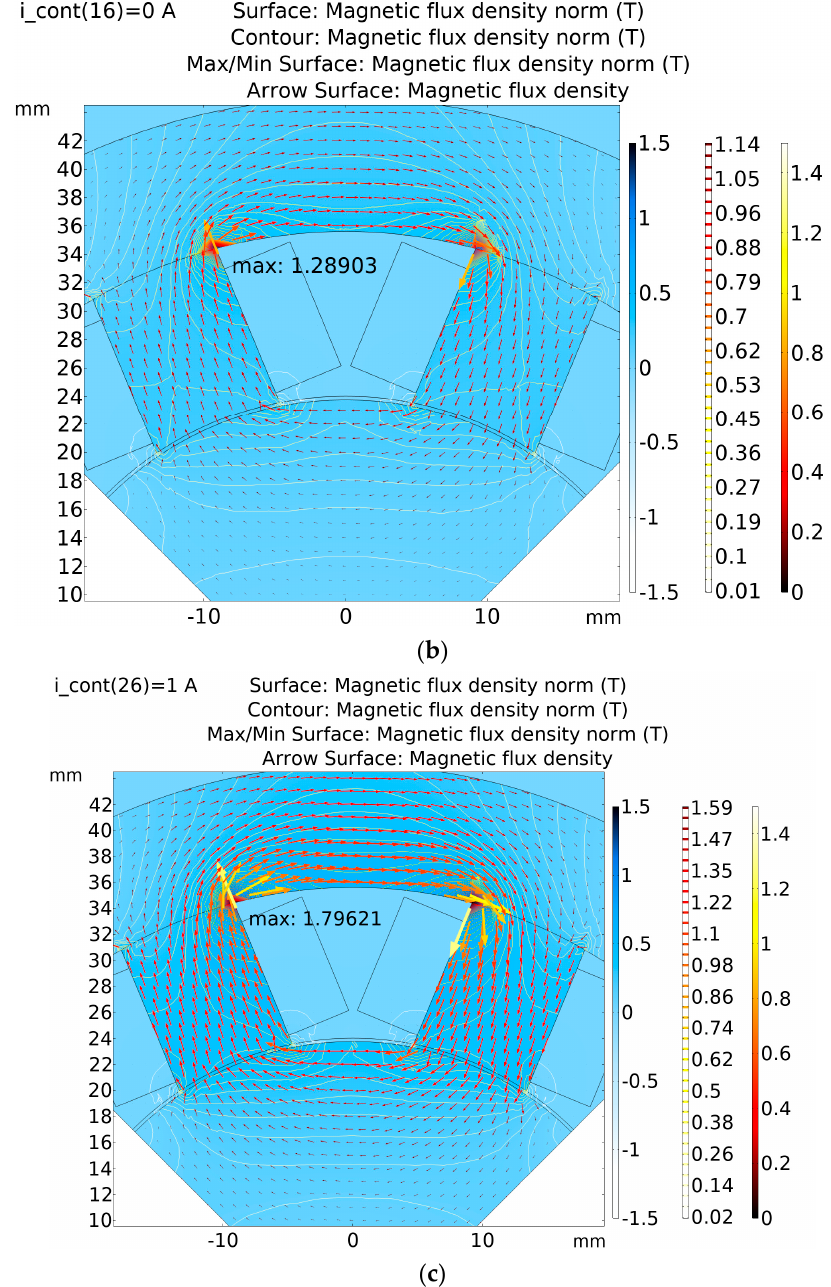
Figure 9. Magnetic flux density for the control current of − 1 A ( a ), 0 A ( b ), and 1 A ( c ).